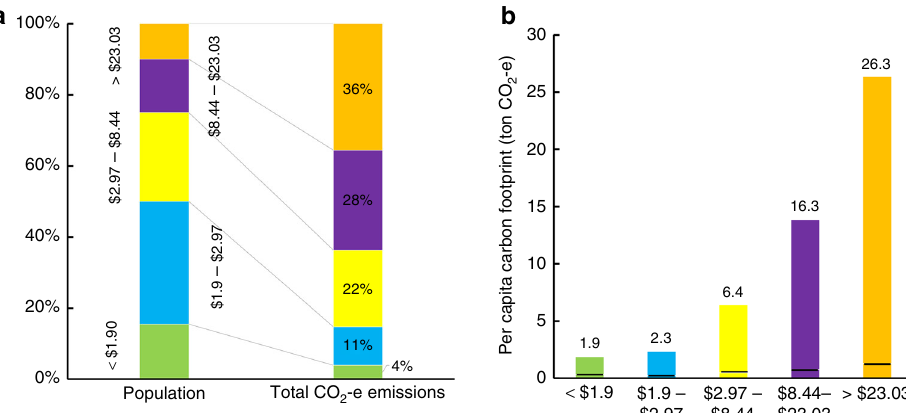
Fig. 1 Global income and carbon distribution in 2010 for household fi nal demand plus associated government expenditure and capital formation. a Global population share and global carbon contribution per expenditure category. Colors represent different expenditure categories and their respective shares of the global population and global carbon emissions. b Per Capita carbon footprint per expenditure category in tons of CO 2 -e. Dotted line separates the direct and indirect emissions for each consumer groups (lower part is the direct emissions and upper part is the indirect or upstream emissions in the supply chain)